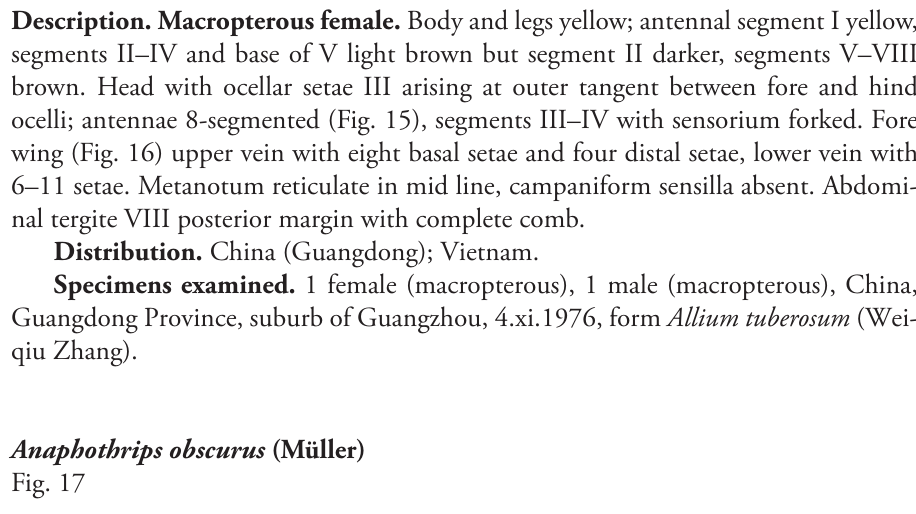
Thrips obscura Müller, 1776: 96. Description. Macropterous female . Body and legs yellow; antennal segment I yel- low, segments II-IV light brown but segment II darker, segments V-IX brown but segment V paler slightly; fore wing weakly shaded. Head wider than long, dorsal surface sculptured with irregular transverse reticulations behind eyes; ocellar setae I present, ocellar setae III out of ocellar triangle just anterior to hind ocelli. Antennae 9-segmented (Fig. 17), segments III–IV with sense cone forked. Fore wing upper vein with 7–8 basal setae and 2–3 distal setae, lower vein with 8–9 setae. Abdomi- nal tergites with microtrichia laterally, tergite VIII posterior margin with comb of microtrichia. Micropterous male. Similar to macropterous female, but wing shorter than tho- rax width (Mound and Masumoto